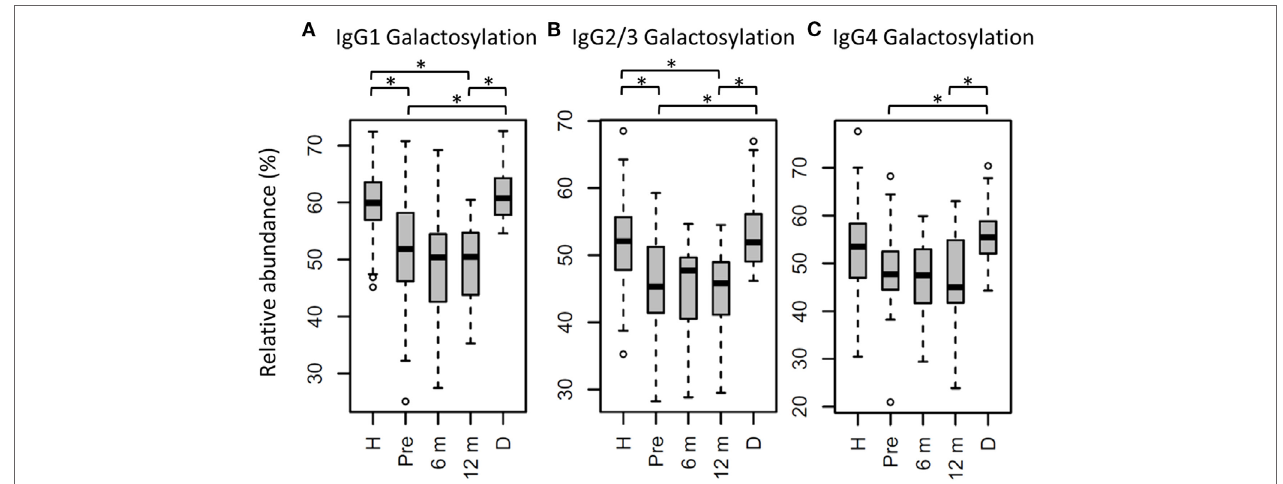
FigUre 3 | Immunoglobulin G (IgG) fragment crystallizable (Fc) galactosylation in all patients, compared to their donors and age-matched healthy controls. IgG Fc galactosylation on (a) IgG1, (b) IgG2/3, and (c) IgG4 is different between patients before hematopoietic stem cell transplantation (HSCT) (Pre) and their donors (D). No changes were observed between patients pre- and 12 months post-HSCT (12 m). In general, patients before and after HSCT have lower galactosylation than age-matched healthy controls (H), although this was not statistically significant for IgG4 galactosylation. 6 m: patients 6 months after HSCT. Patients and donors were compared by Wilcoxon signed-rank tests, healthy controls and patients with Mann–Whitney U tests. p -Values < 0.015 were considered statistically significant after 5% FDR correction (as indicated by the asterisks above the plots). For IgG1 galactosylation, n (H, Pre, 6 m, 12 m, D) = 81, 32, 34, 34, 29, for IgG2/3 galactosylation, n (H, Pre, 6 m, 12 m, D) = 69, 32, 32, 33, 29, for IgG4 galactosylation, and n (H, Pre, 6 m, 12 m, D) = 59, 27, 15, 17, 28,